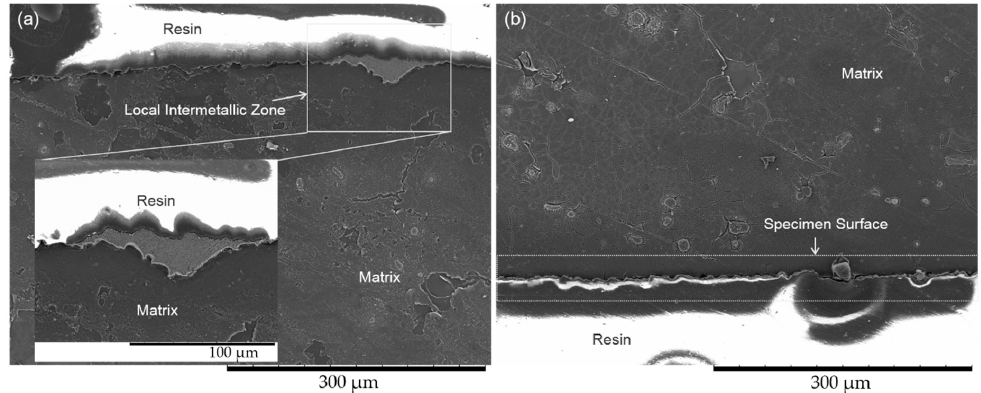
Figure 9. The cross sections of the as-di ff usion alloyed intermetallic layer fabricated with the di ff usion 9 source containing 5 g of NH 4 Cl powder, 10 g of Al powder and 10 g of Al 2 O 3 powder. Few intermetallic zones with limited sizes ( a ) could be found on the cross sections and most of the specimen surface is without any coating ( b